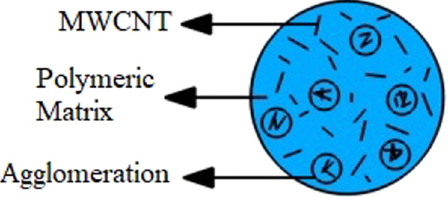
Figure 1: An EMT ’ s RVE, which shows randomly oriented MWCNTs and their agglomerations, are dispersed in a polymeric